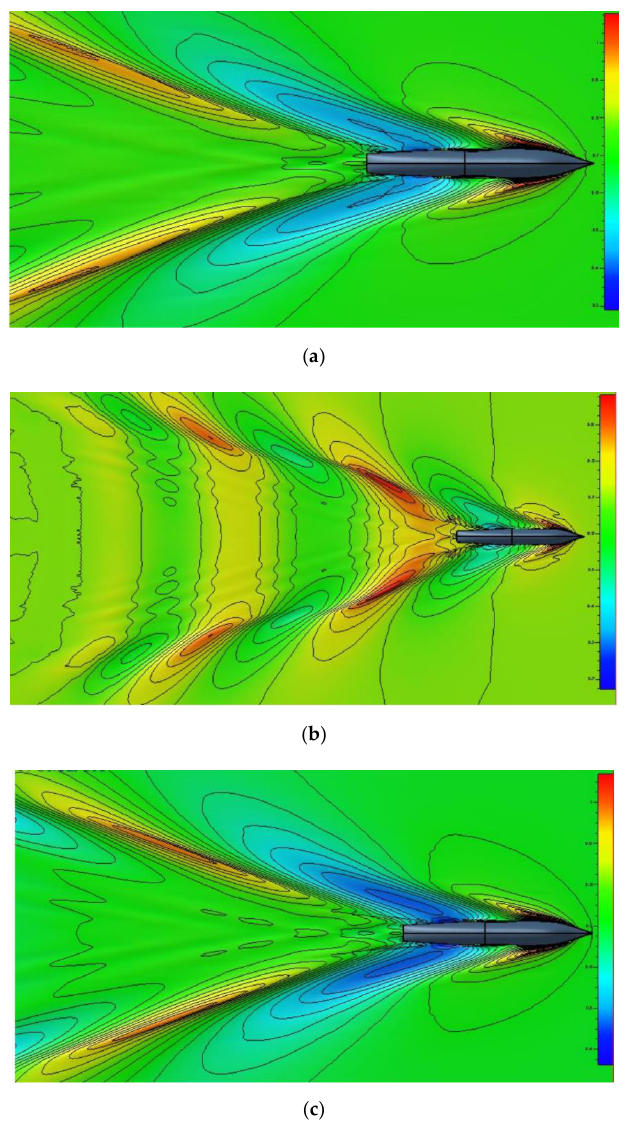
Figure 10. Different deadrise angle configuration with Froude number 0.6; ( a ) 20°; ( b ) 25°; ( c ) 35°.